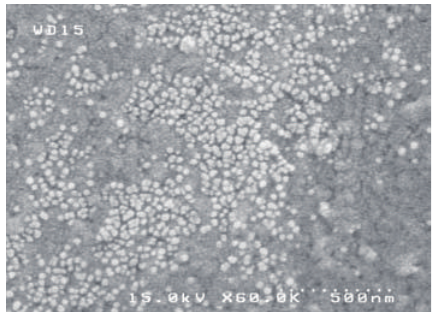
F 3: FESEM images of CdO nanoparticles at 500nm scale.